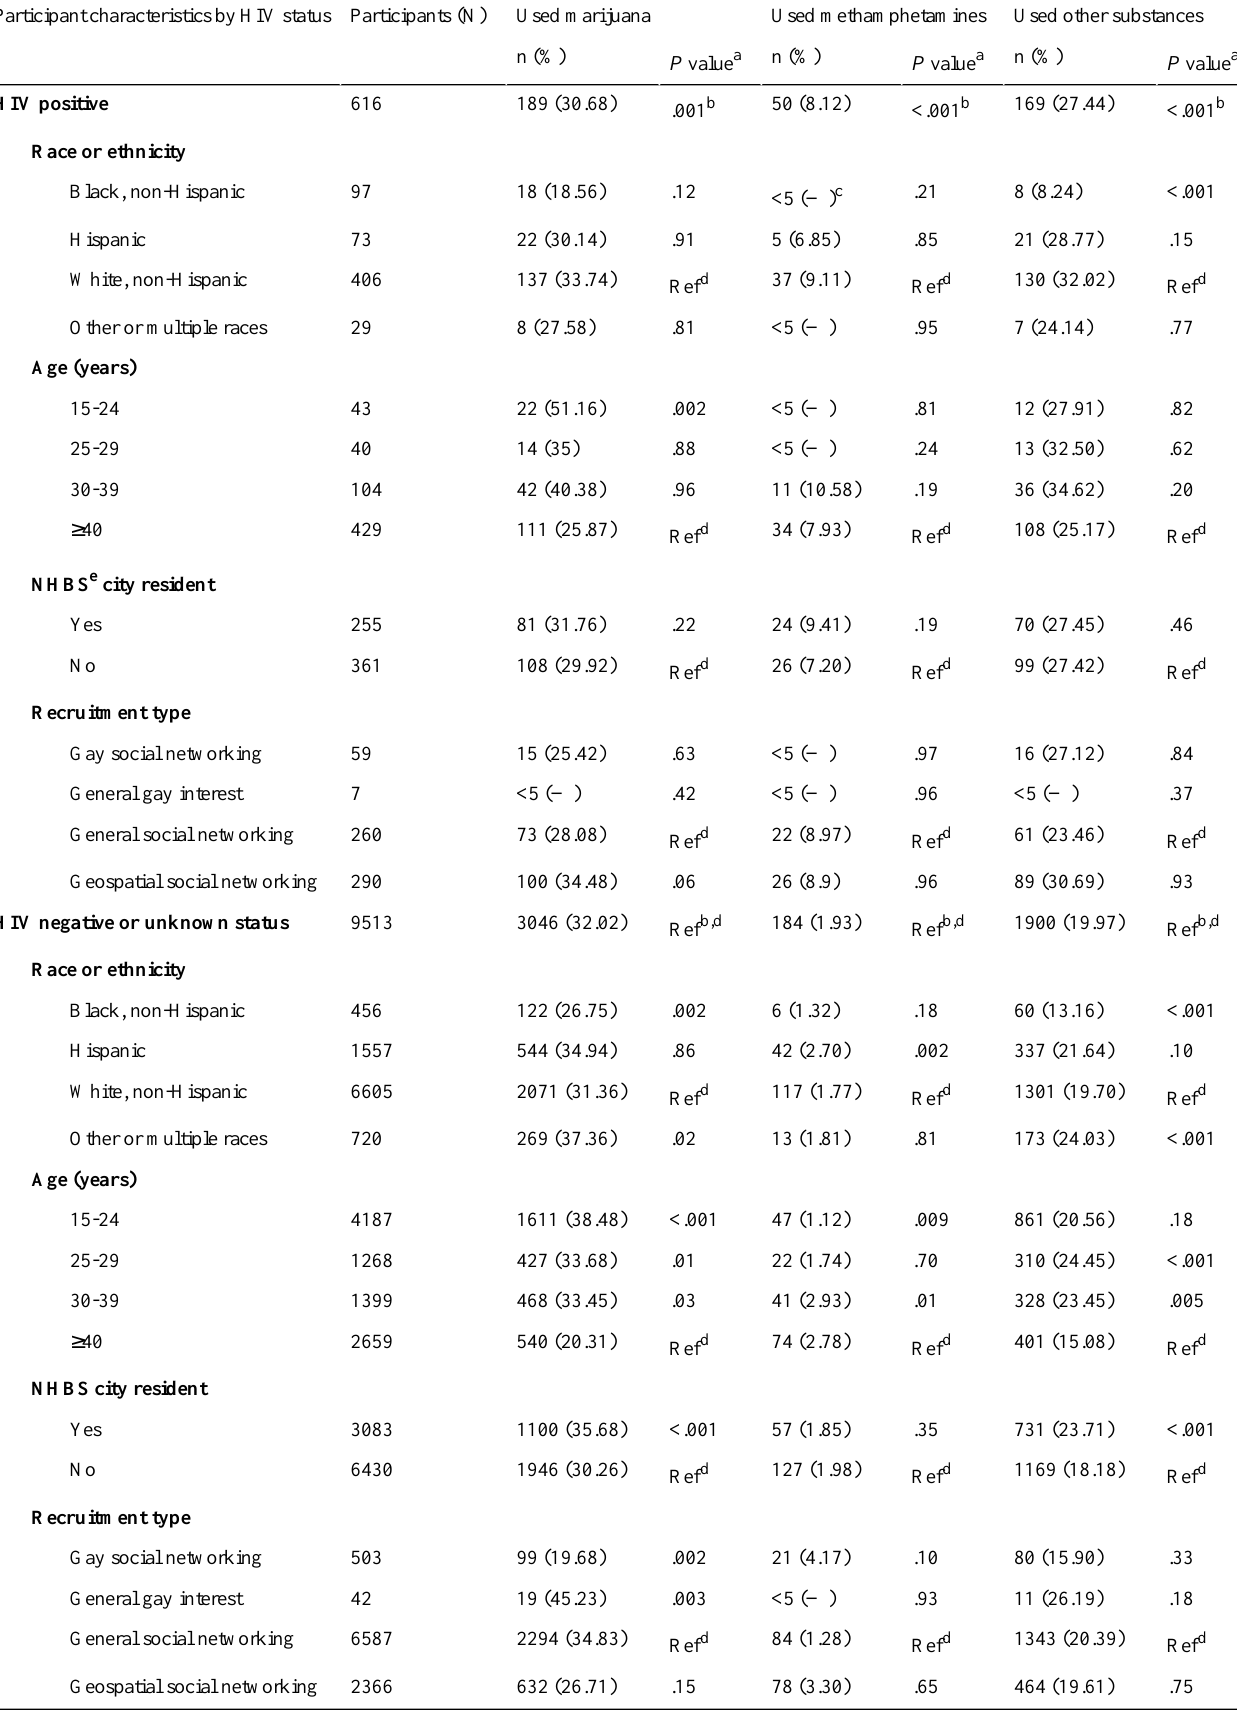
Table 4. Substance use behaviors of men who have sex with men in the American Men’s Internet Survey, United States, 2018.